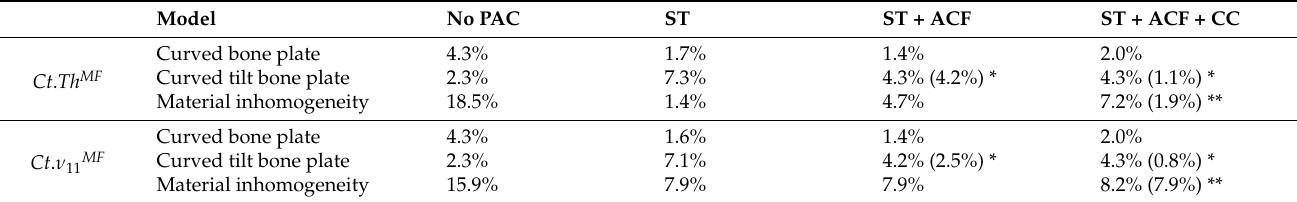
Table 3. Precision of Ct . Th MF and Ct . ν 11 MF after each PAC method.